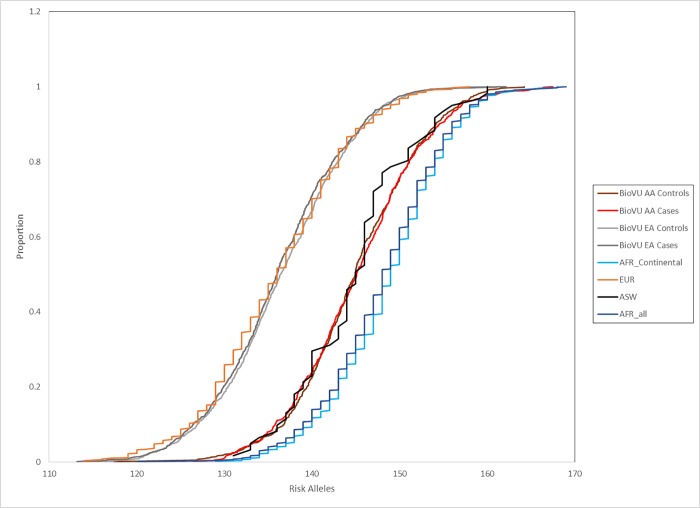
Cumulative distribution of GRS in 1000 Genomes AFR, EUR, ASW, and BioVU populations.*AFR includes only the continental African populations.